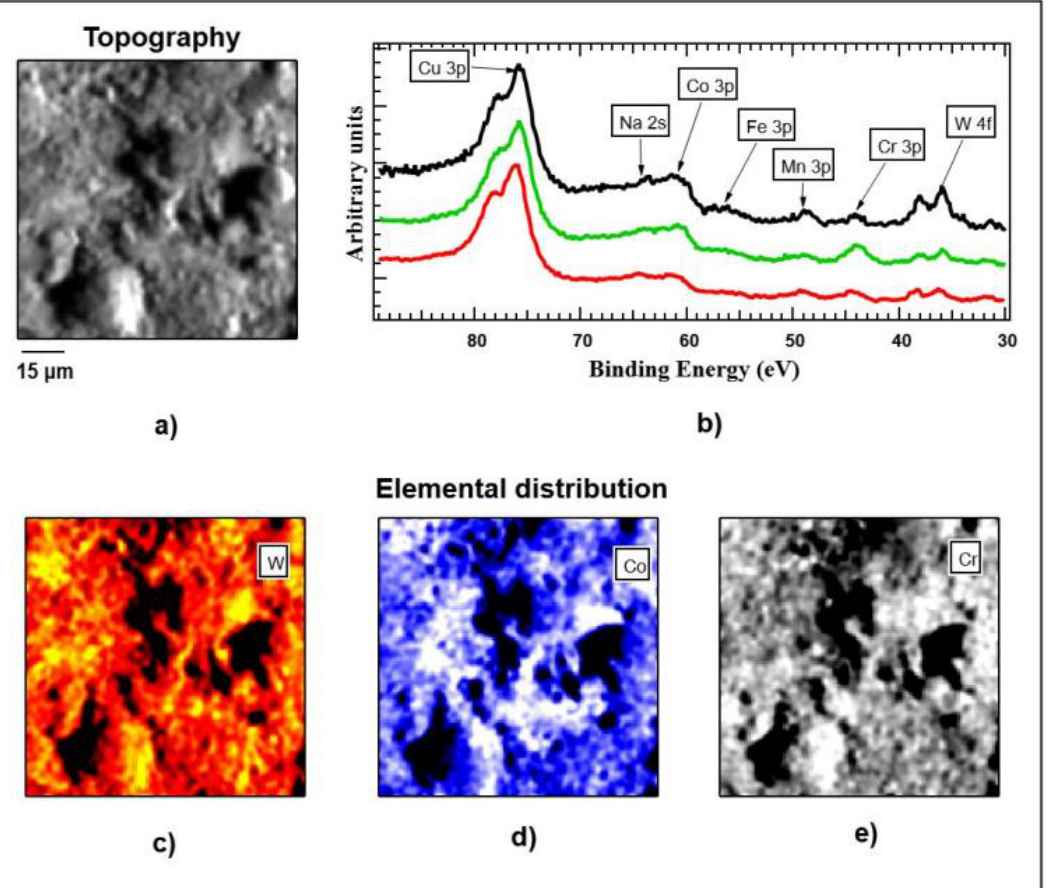
Figure 12. Scanning X-ray photoelectron microscope (SPEM) map of the unpolished sample covered by graphene. The contrast present in the image is dominated by surface topography ( a ): brighter areas are associated with features which are oriented towards the hemispherical electron energy analyzer (HEA), while dark regions represent shadowed areas or holes in the surface. X-ray photoelectron spectroscopy (XPS) spectra ( b ) acquired at different representative positions. ( c ), ( d ), and ( e ) — elemental distribution of W, Co, and Cr, respectively. The black areas visible in the images must be ignored because of the intensity of the photoemission signal detected from these areas, which is too poor to be correctly processed. Changes in the color scale reflect the variations in the elemental concentration.